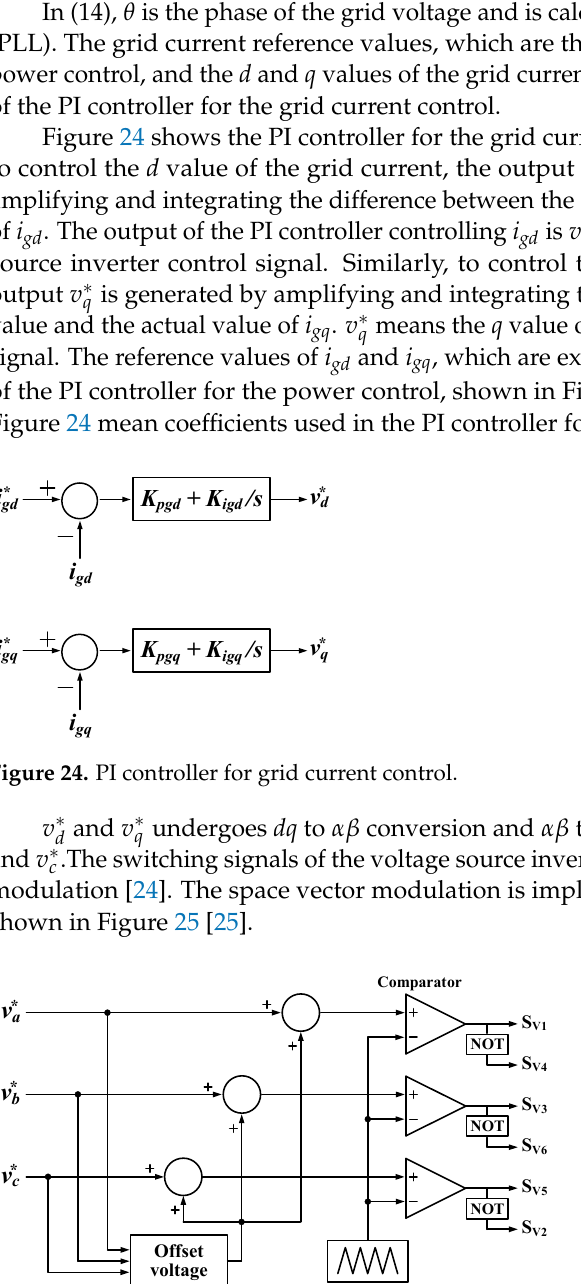
Figure 25. PI controller for power control. Figure 25. Space vector modulation using the offset